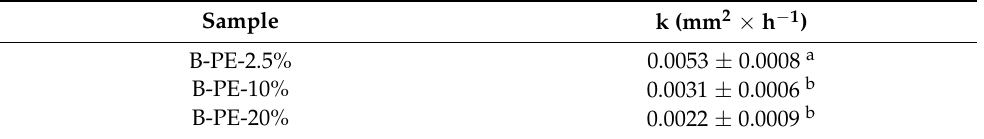
Table 5. k parameters obtained from fitting of experimental data applying Equation